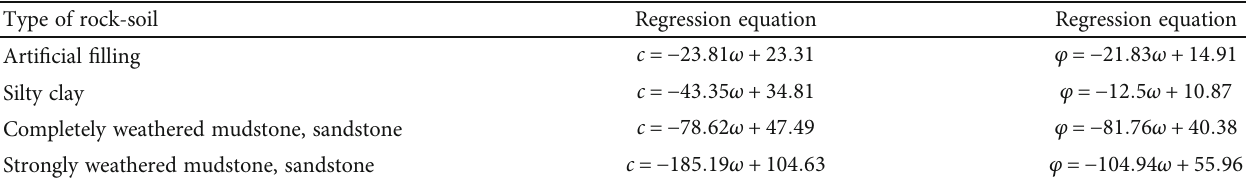
Table 5: The regression equation of the relationship between water content and cohesion and internal friction angle. Type of rock-soil Regression